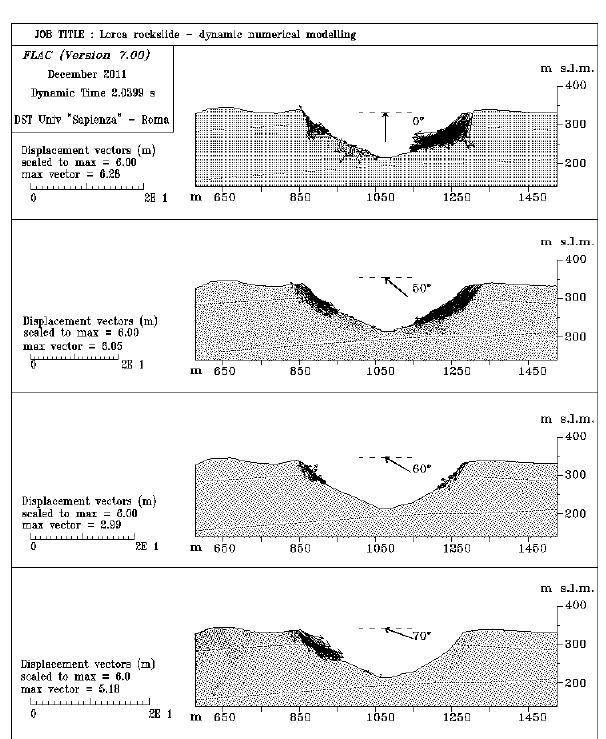
Fig. 8. Total displacements resulting by the FLAC dynamic numer- ical modeling after the seismic wave propagation at various inci- dence